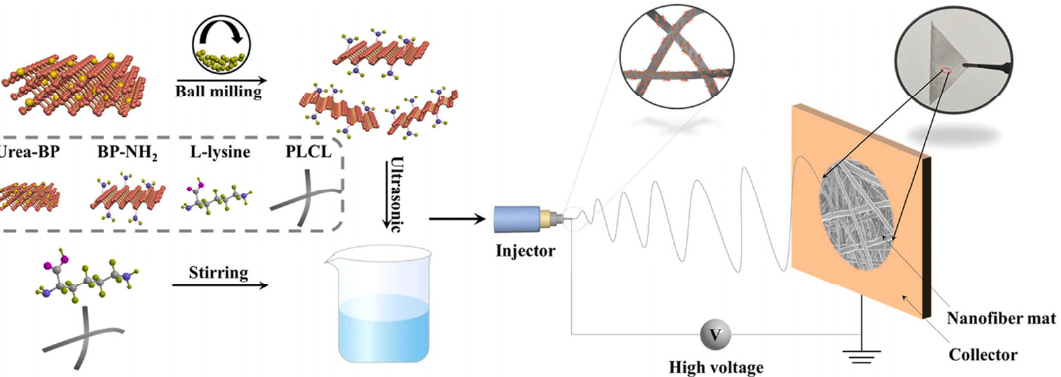
Figure 3. The PLCL/L-NH-BP nanocomposite scaffold prepared by electrospinning can promote the osteogenic differentiation of mesenchymal stem cells. Reproduced with permission from [72], Col- loids and Surfaces B-Biointerfaces, 2022.